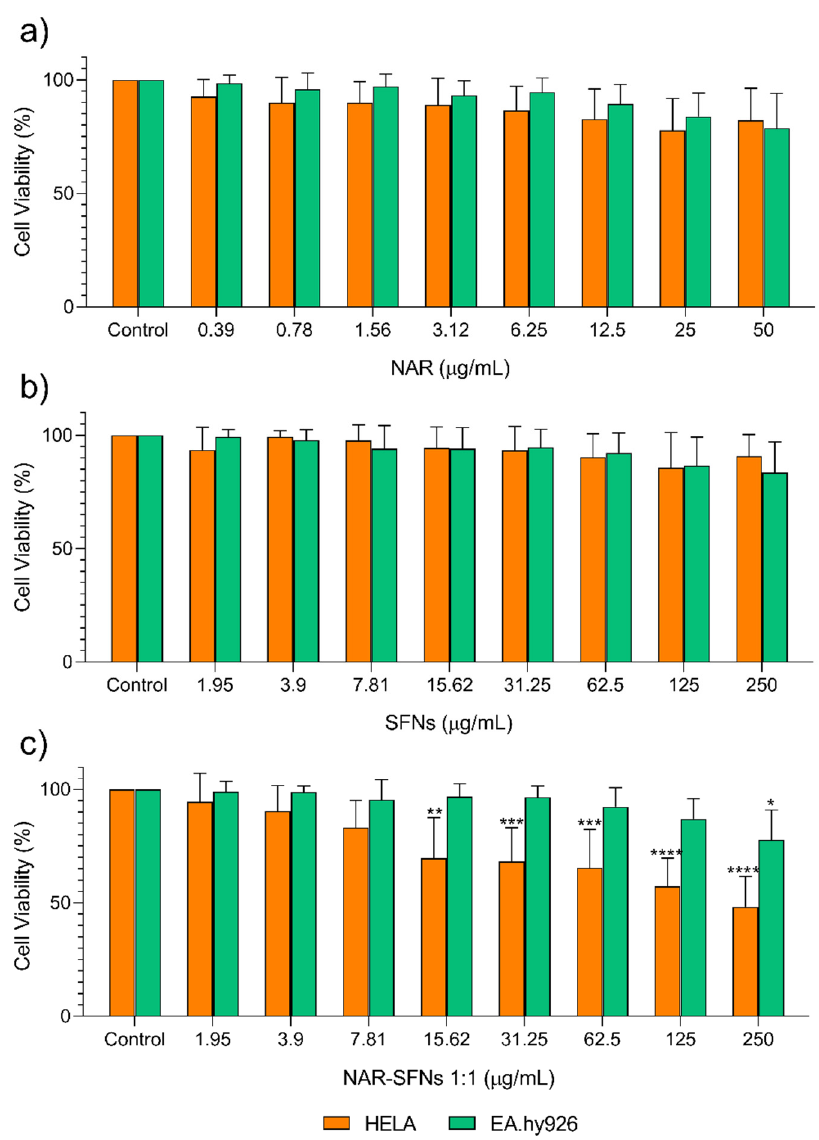
Figure 5. Cytotoxicity e ff ect of free NAR ( a ), SFNs ( b ) and NAR-SFNs 1:1 ( c ) on HeLa and EA.hy926 cell lines. Data are expressed as percentage of cell viability ± SD versus concentration. * indicates p < 0.05, ** indicates p < 0.01, *** indicates p < 0.001 and **** indicates p < 0.0001, compared to control.